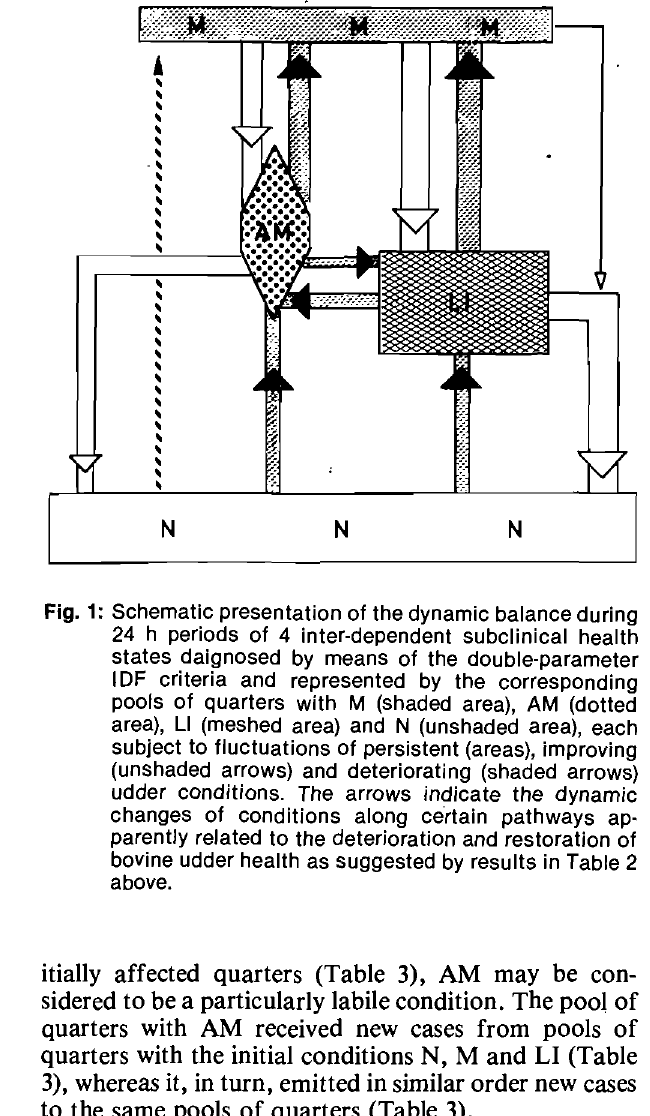
Fig. 1: Schematic presentation of the dynamic balance during 24 h periods of 4 inter·dependent subclinical health states daignosed by means of the double-parameter IOF criteria and represented by the corresponding pools of quarters with M (shaded area), AM (dotted area), LI (meshed area) and N (unshaded area), each subject to fluctuations of persistent (areas), improving (unshaded arrows) and deteriorating (shaded arrows) udder conditions. The arrows indicate the dynamic changes of conditions along certain pathways ap parently related to the deterioration and restoration of bovine udder health as suggested by results in Table 2